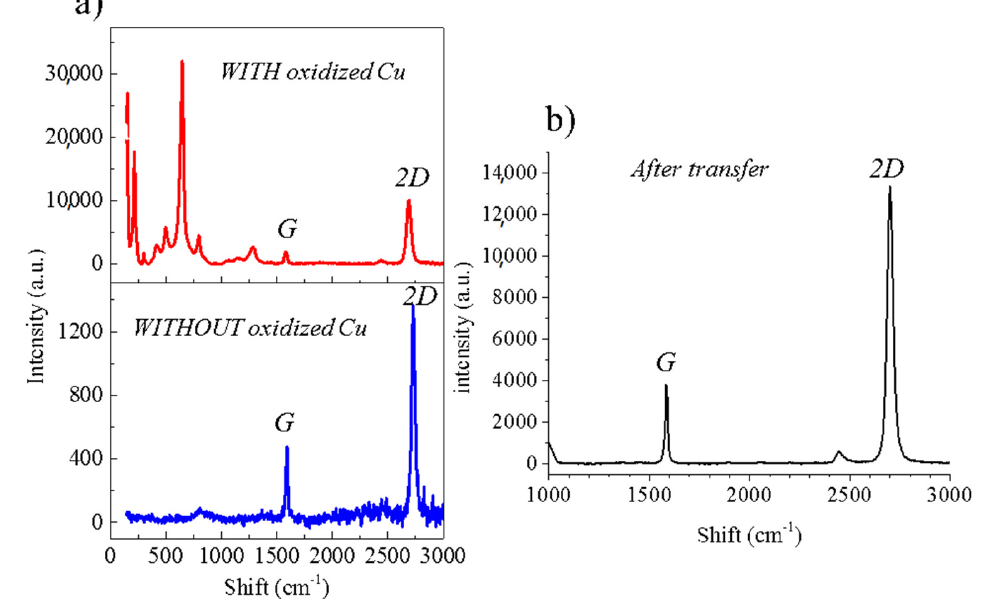
Figure 5. Raman spectra of graphene from Figure 1c after subtracting the baseline. ( a ) Red represents an area where graphene is on Cu oxide, blue represents an area where graphene is on Cu. Both spectra are obtained on the same graphene crystal ( b ) after transfer on SiO 2 .